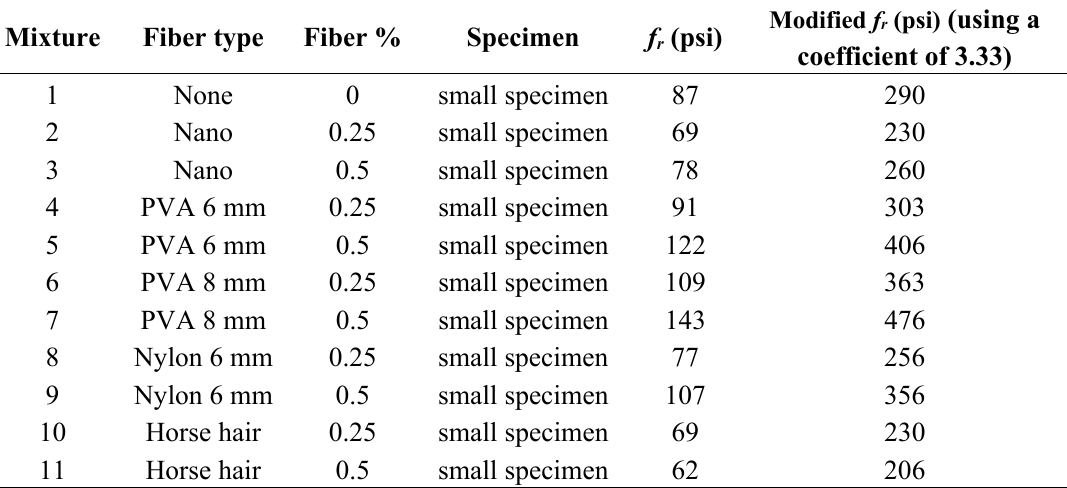
Table 2. Phase 2 test matrix and